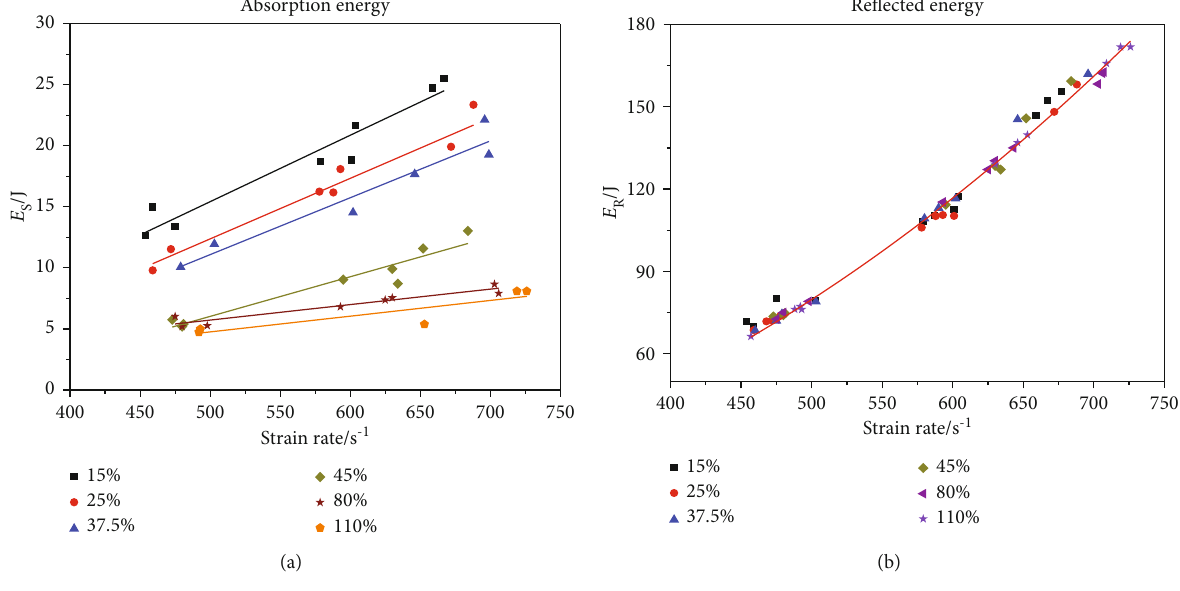
Figure 6: The variation in absorption energy and re fl ected energy with strain rate.